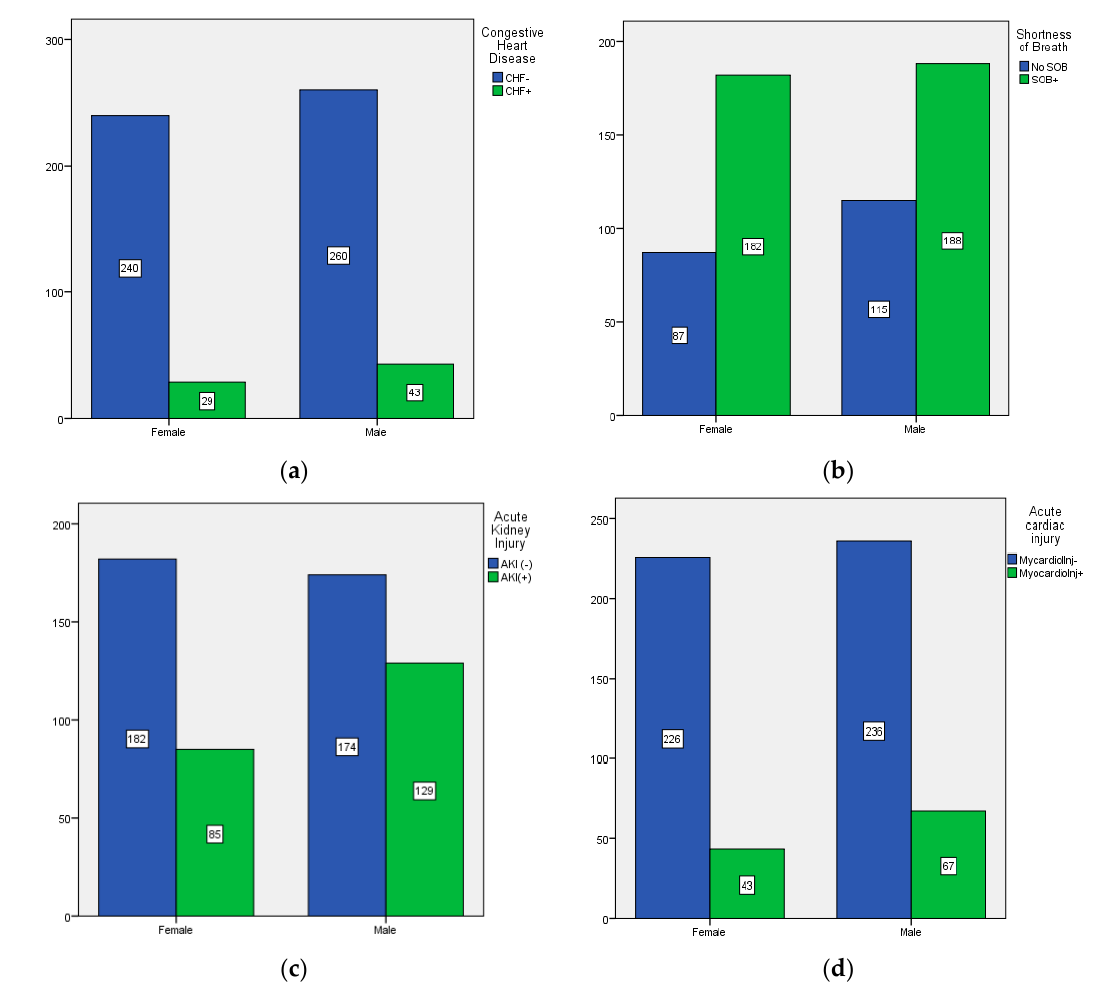
Figure 5. Differentiating survived and expired COVID-19 patients with corresponding: ( a ) cognitive heart disease symptoms, ( b ) shortness of breath symptoms, ( c ) acute kidney injury, and ( d ) acute cardiac injury.